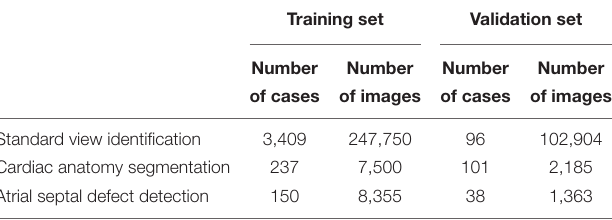
TABLE 1 | Summary of the training and validation data